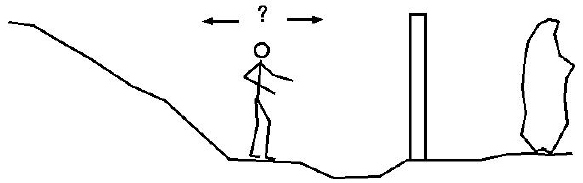
Figure 2. Should you walk towards or away from the wall to see what is beyond